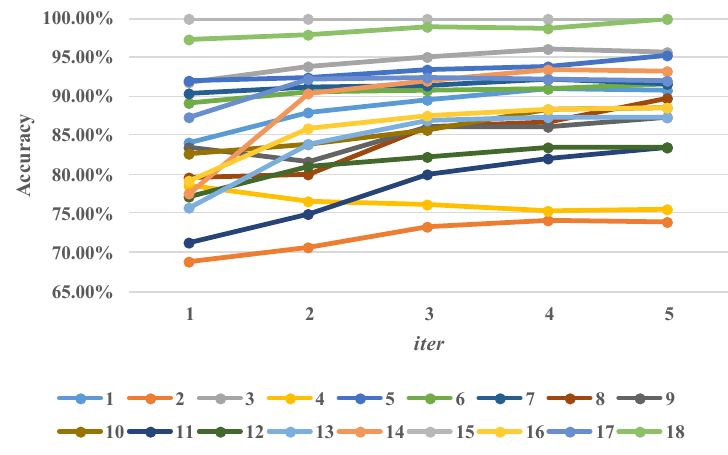
Figure 6. Performance (accuracy, %) of each subtask.